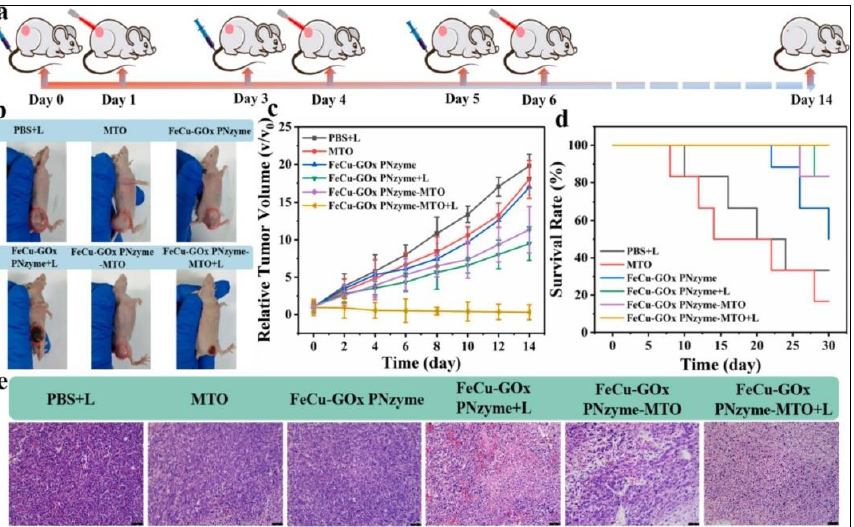
Figure 6. In vivo antitumor effect in mice bearing a 4T1 tumor, treated with (1) PBS + Light; (2) MTO; (3) FeCu-GOx PNzyme; (4) FeCu-GOx PNzyme + Light; (5) FeCu-GOx PNzyme-MT; and (6) FeCu- GOx PNzyme-MTO + Light. The data was shown as means ± SD ( n = 5): ( a ) schematic illustra- tion of the in vivo experimental schedule; ( b ) photographs of mice and tumors from various mice groups post-treatment; ( c ) time-dependent tumor growth curves; ( d ) Kaplan–Meier diagram of time-dependent cumulative surviving profiles of various study groups; ( e ) hematoxylin and eosin (H and E)-stained images of tumor slices collected from various study groups of tumor-bearing mice. Scale bar: 75 µ m. Reprinted with permission from Ref. [87]. Copyright 2022